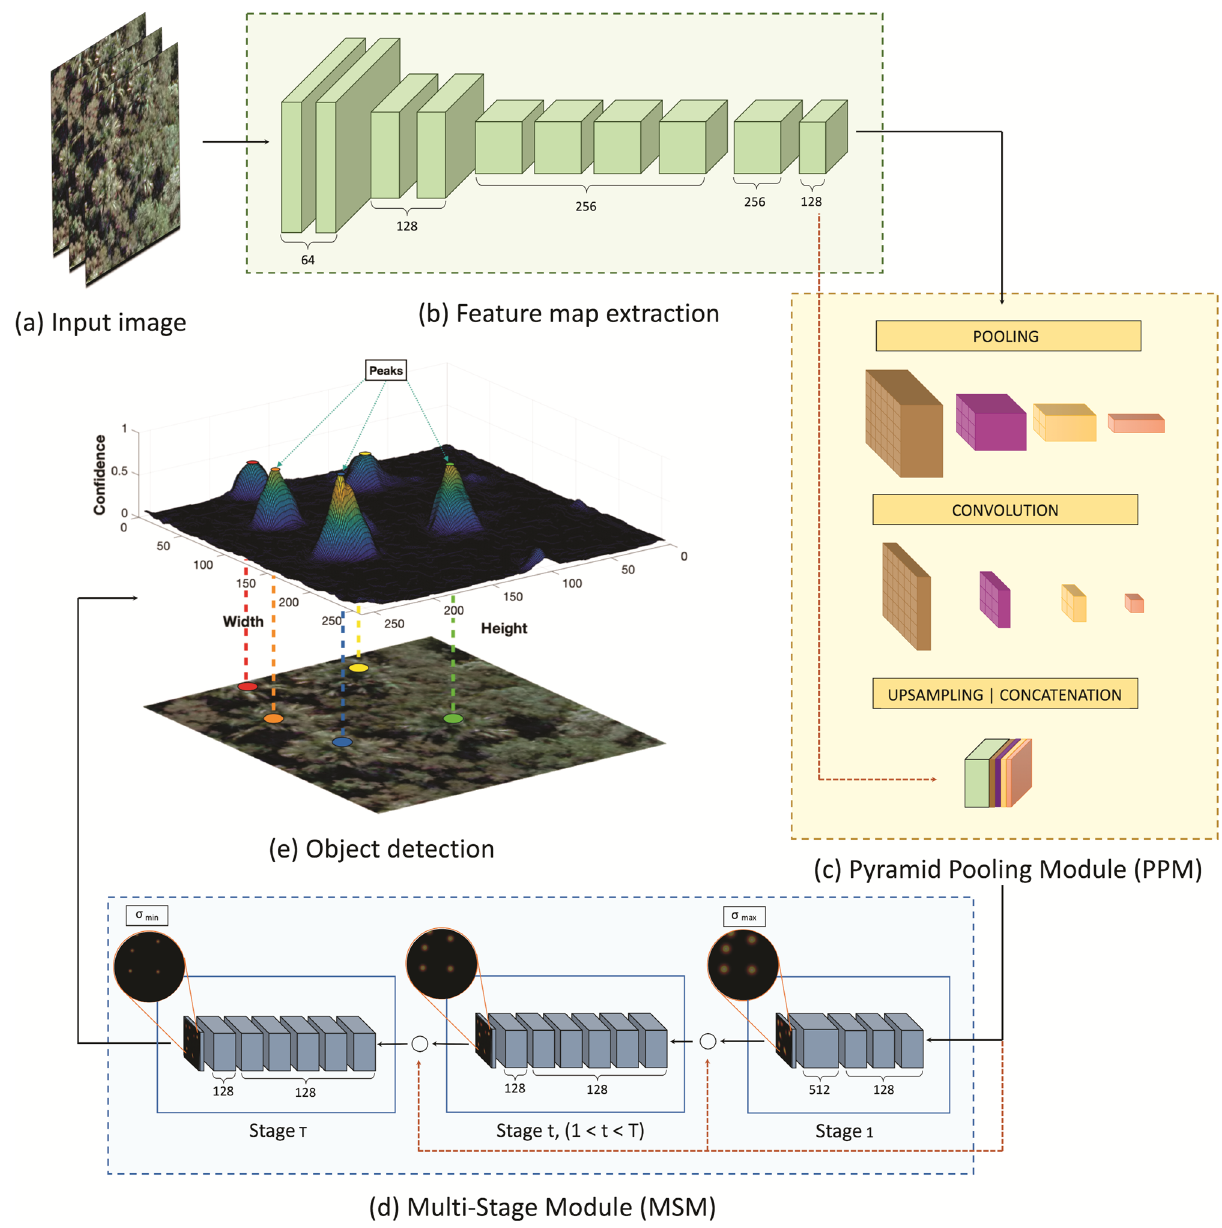
Figure 7. Proposed CNN. The feature map ( b ) is extracted from the input image ( a ) and improved by the PPM ( c ). The result is used as input at the MSM step ( d ), where T stages enhance the prediction positions ( e